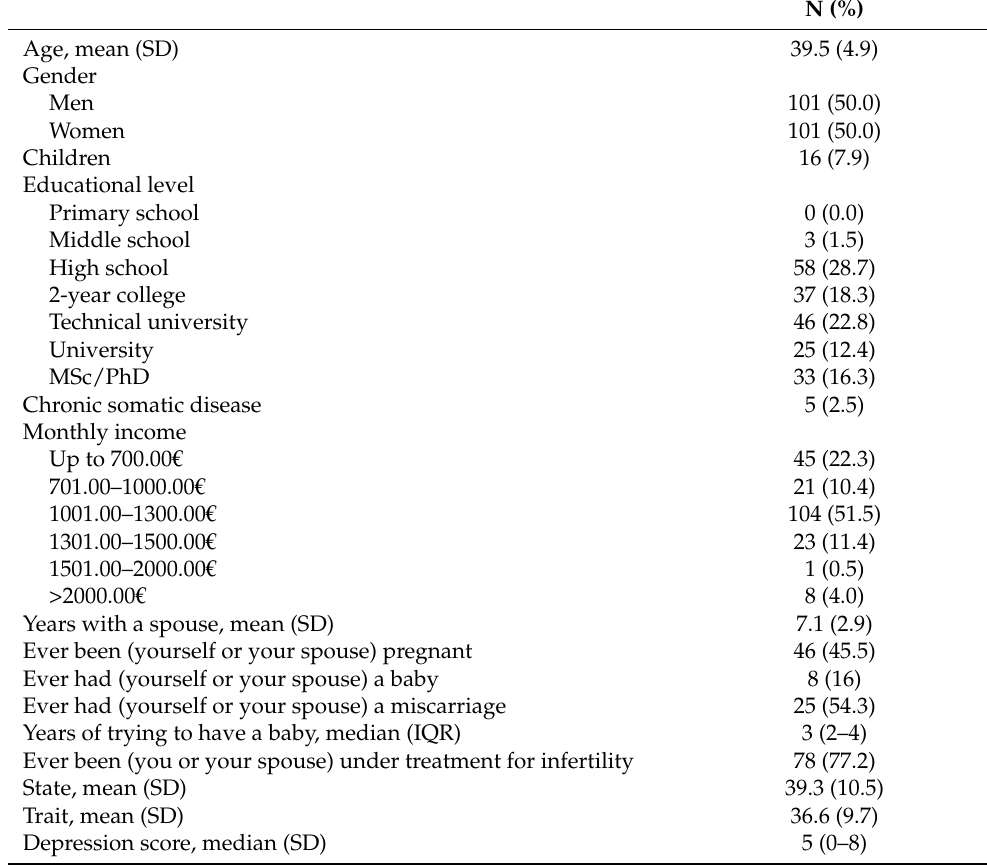
Table 1. Sample characteristics.